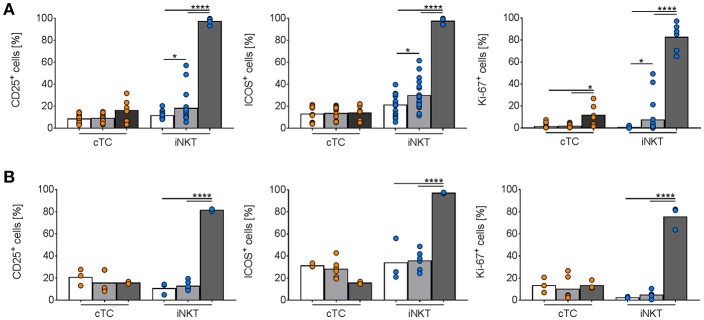
In vitro activation of porcine iNKT cells during viral infections. Freshly isolated porcine PBMC were incubated without stimulation (white bars) or in the presence of supernatant of purified CD172a+ cells infected with (A) IAV (MOI 1; gray) or (B) ASFV (MOI 0.1; gray), or 1 μg/ml αGC (black) for 4 days. Frequencies of iNKT cells (blue circles) and cTC (orange circles) positive for CD25, ICOS, and Ki-67 are shown. Pooled data of two experiments with six individual pigs for IAV and three individual pigs for ASFV shown as mean (SD), *p < 0.05, ****p < 0.0001, ordinary one-way ANOVA with Holm-Sidak's post-hoc test for multiple comparisons.